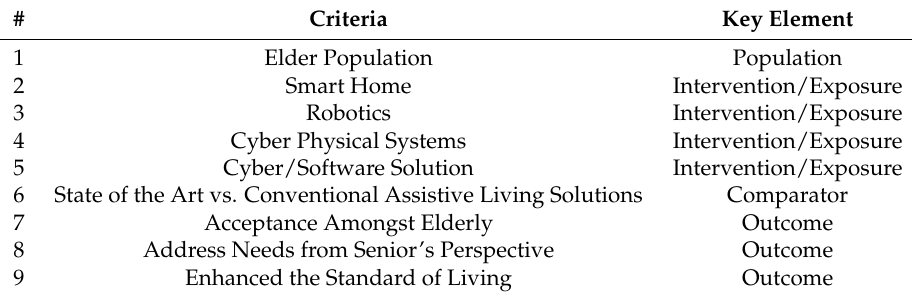
Table 1. PICO criteria for selecting